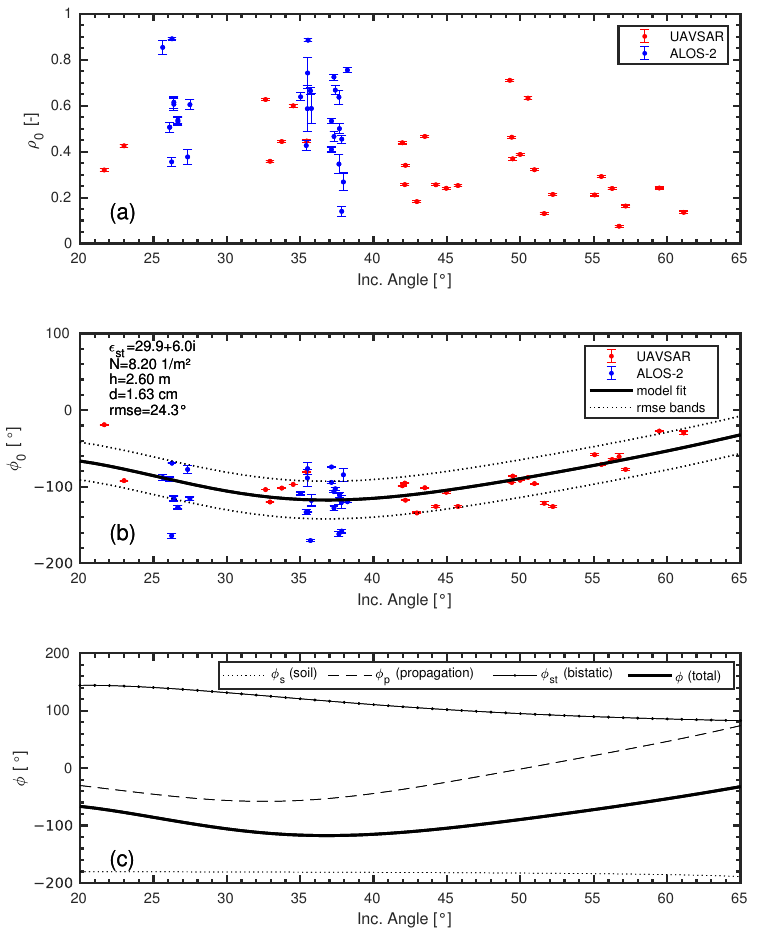
Figure 5. Model fitting by nonlinear least-squares and estimated parameters. ( a ) Coherence ρ 0 . ( b ) Co-polarized phase difference φ 0 and model fitting. The fitted parameters are indicated. ( c ) Each contribution to the total phase difference is shown